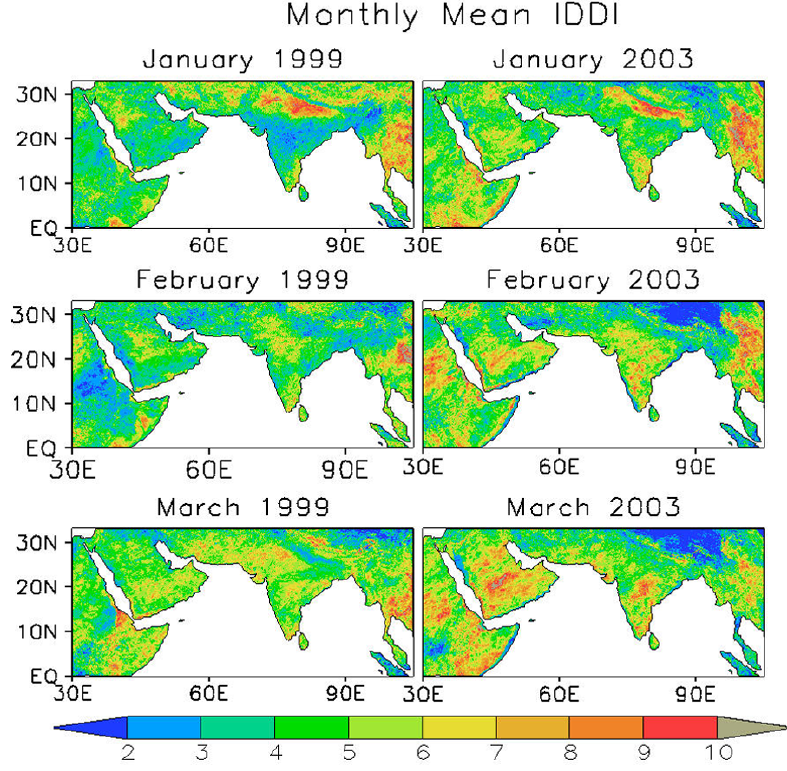
Fig. 23. Regional distribution of IDDI (K) for January, February and March (1999 and 2003).